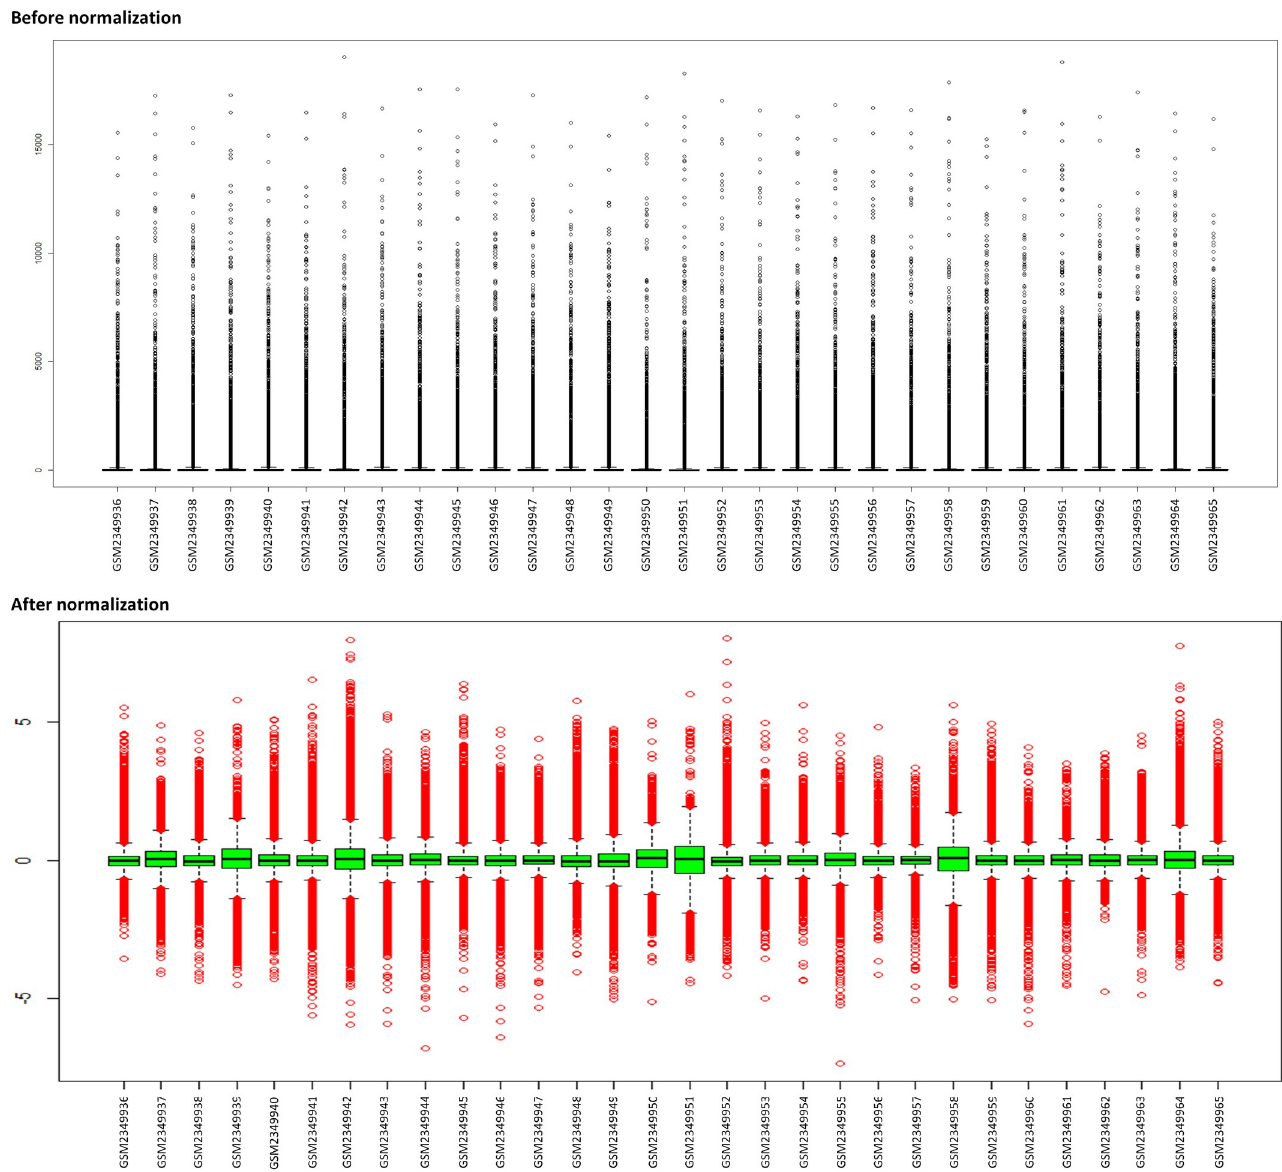
Fig 1. Pre and post-normalization of microarray gene expression data. Samples are represented on horizontal axis and the gene expression values on vertical axis.